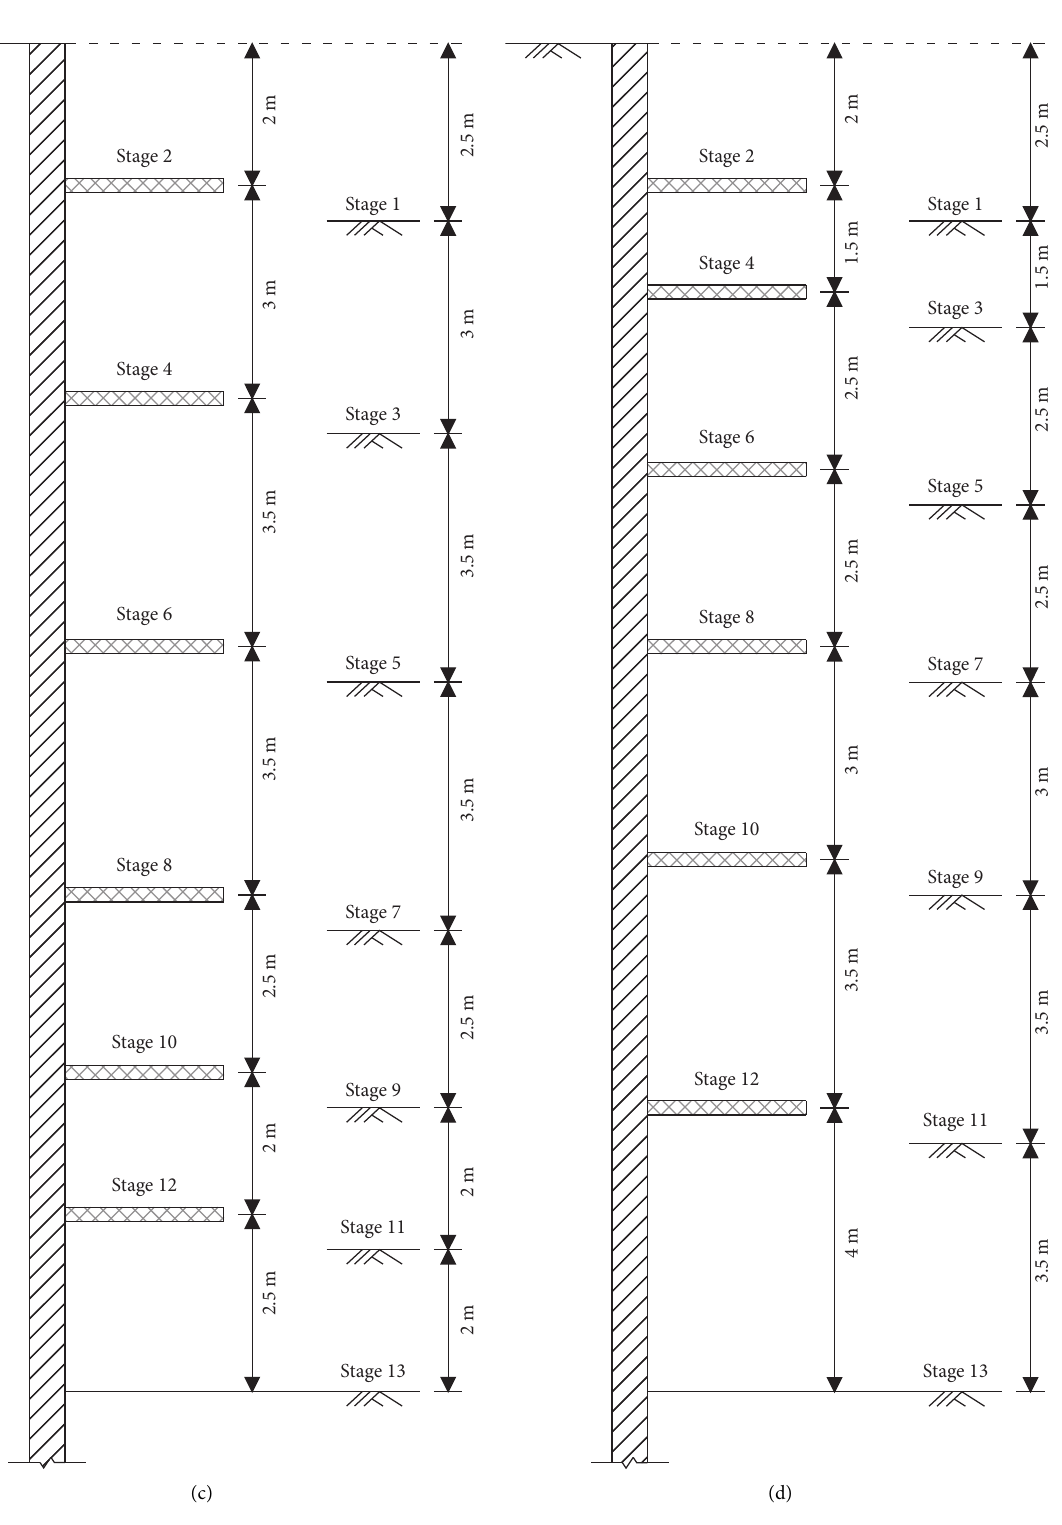
Figure 2: Schematic diagram of the hypothetical deep excavation cases, modified from